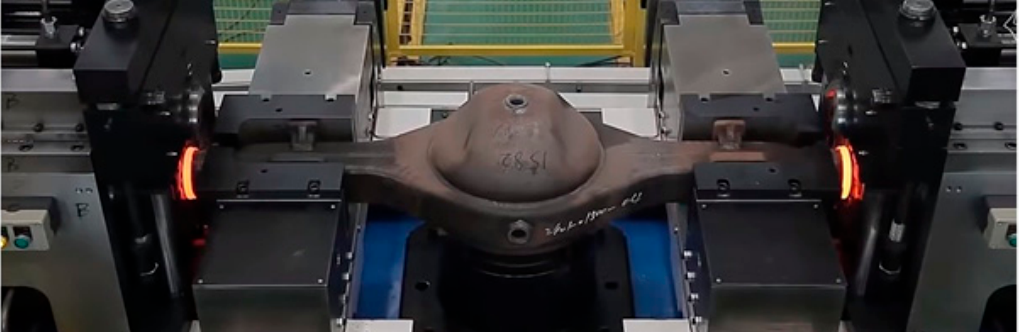
Figure 11. Friction welding of axles (China RCM). Appl. Sci. 2020 , 10 , x FOR PEER REVIEW